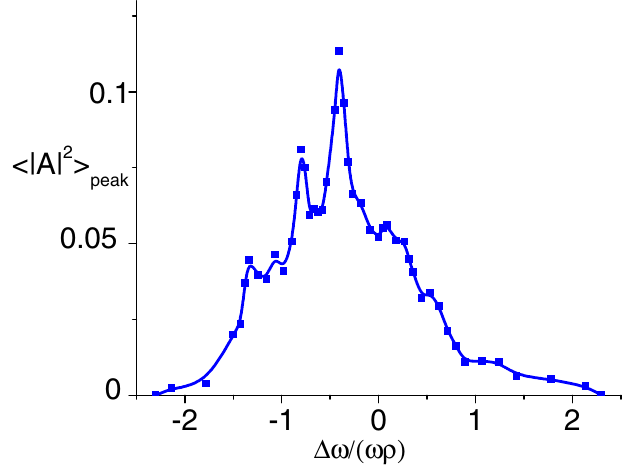
FIG. 3. (Color) First peak value of hj A j 2 i versus (cid:4) != (cid:2) !(cid:9) (cid:3) for parameters similar to those of Fig.